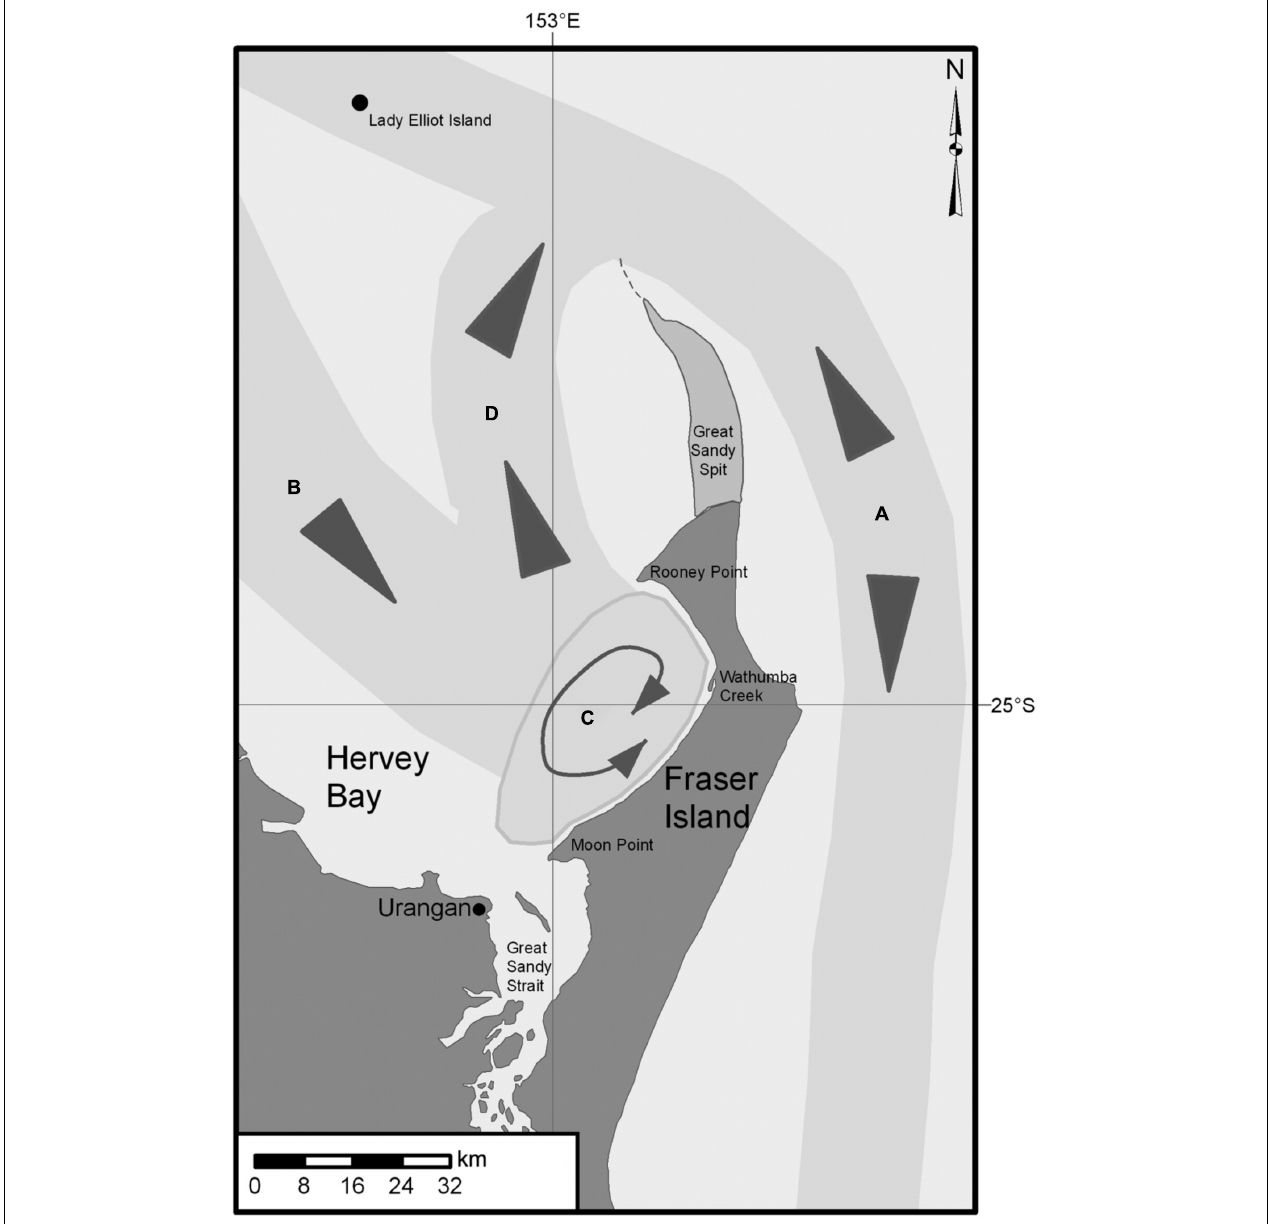
FIGURE 2 | Humpback whale migratory pathways into and out of Hervey Bay. Hervey Bay’s northern entrance, east of the northern end of Great Sandy Spit, is 80 km wide with a mean depth of 20 m (Ribbe, 2014). Humpback whales enter (B) and leave Hervey Bay (D) to the north and aggregate in the eastern bay, off the western shore of Fraser Island (C) (Corkeron, 1993; Corkeron et al., 1994; Franklin et al., 2011, 2018). To enter Hervey Bay, humpback whales make a slight diversion from the primary north–south migratory pathway (A) (Paterson, 1991) and traverse shallow waters for approximately 40 km. They contend with 3 m tidal movements and do not return to deeper water until they pass north of Great Sandy Spit (Ribbe, 2014) and rejoin the primary southern migratory pathway (A) .